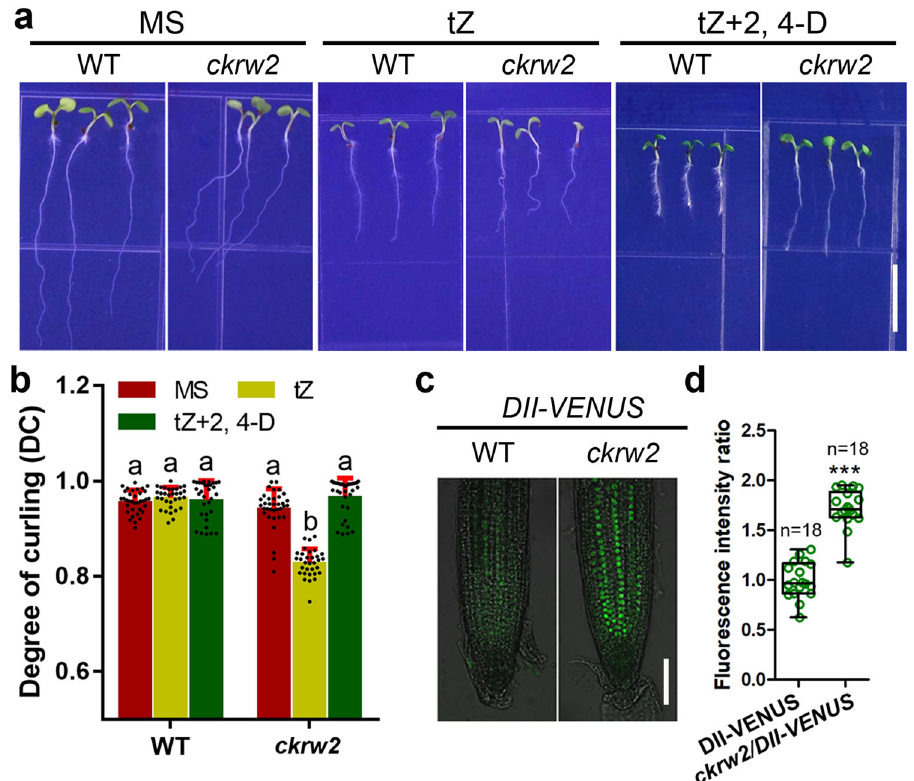
Fig. 1 Auxin-de fi cient phenotypes in ckrw2 mutant. a Auxin-de fi cient phenotypes in ckrw2 mutant, showing its waving roots after 7 days of vertical culture on MS with 0.01 μ M tZ, which can be rescued by 0.01 μ M 2, 4-D. Bar = 5 mm. b Results of statistical analysis on root curling/waving degrees (DC). Data are presented as mean ± SD ( n = 30 – 35), three biologically independent experiments, the letters indicate a signi fi cant difference at P < 0.05 according to ANOVA followed by Tukey ’ s multiple comparison tests. c , d Auxin activity in root tips revealed by the expressions of DII-VENUS . The seedlings grown on MS medium for 7 days were used for GUS staining and fl uorescence intensity observation (approximately to the fi rst 200 µ m from the root tip). Each circle represents the measurement from an individual root. Boxplots span the fi rst to the third quartiles of the data. Whiskers represent the minimum and maximum values. A line in the box represents the mean. “ n ” represents the number of roots used in this experiment. The student ’ s t test, was used for statistical analyses. *** P < 0.001. Bars = 50 µ m in ( d